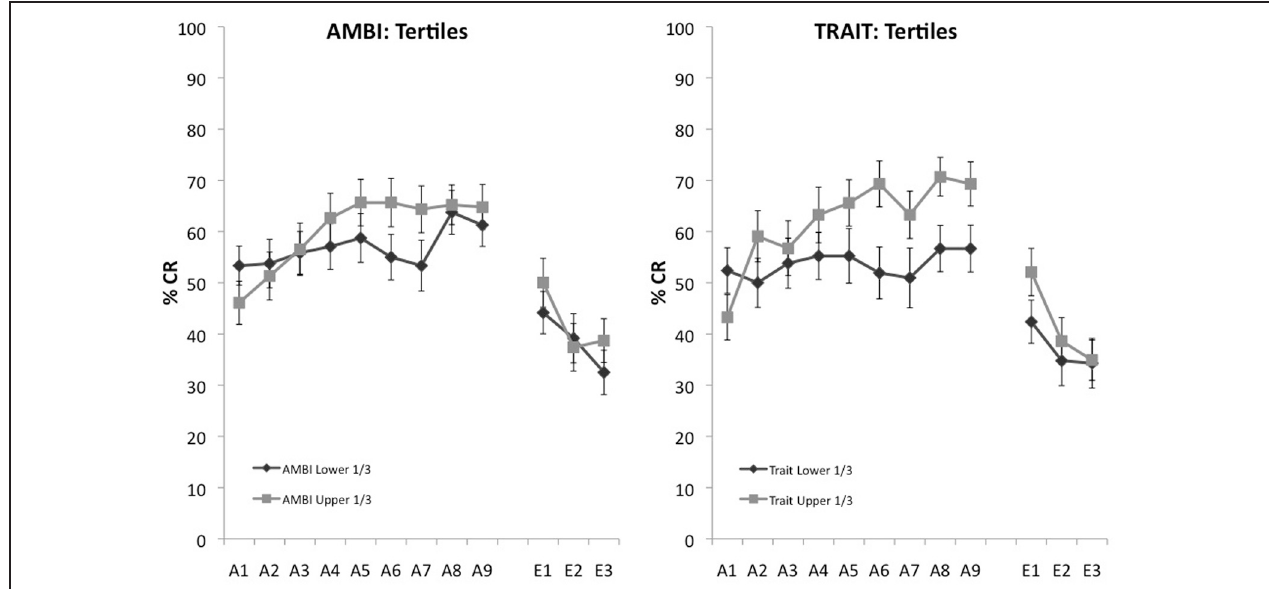
FIGURE 2 | Eyeblink conditioned responding of the upper and lower 1/3 of scores on AMBI and Trait. Significant differences of CR acquisition remain for extreme scoring groups for both the AMBI and Trait